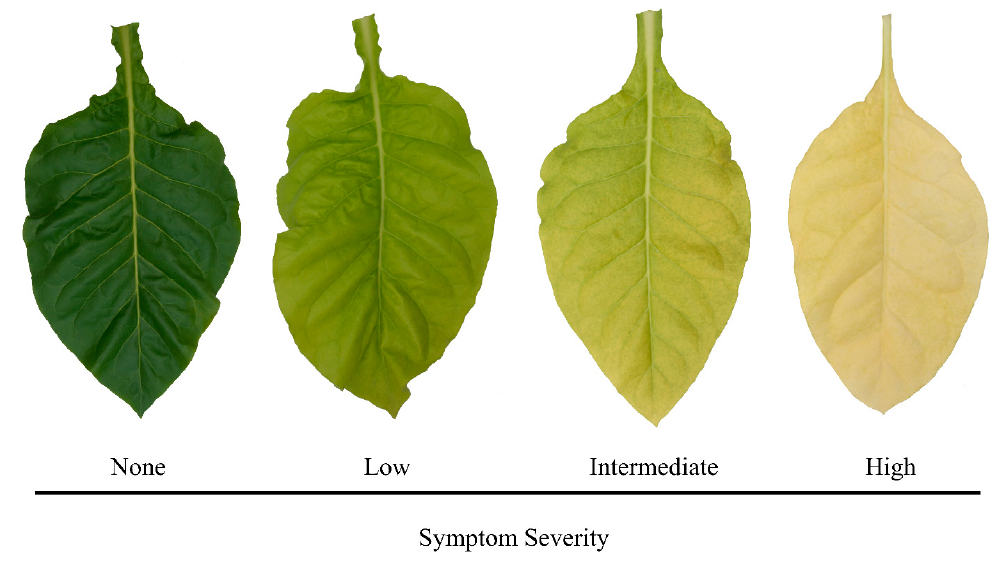
Figure 5. Demonstration of the flue-cured tobacco ( Nicotiana tabacum L.) symptom severity rating system using nitrogen (N) deficiency as an example.